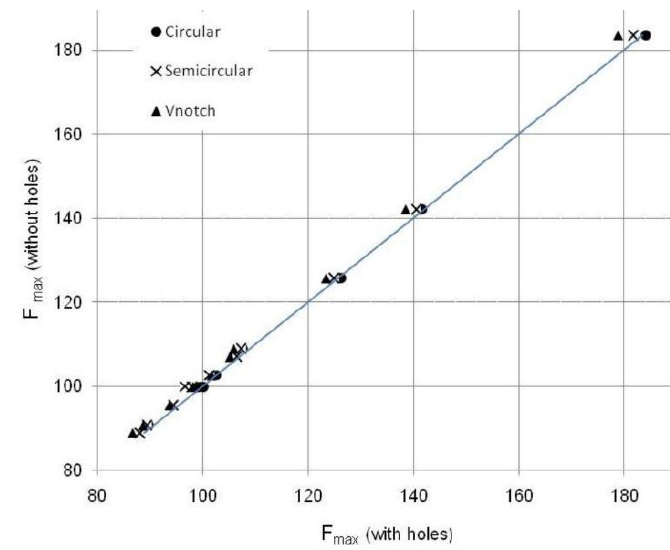
Figure 10. Comparison of maximum load in the joints with and without vent holes. Appl. Sci. 2019 , 9 , x FOR PEER REVIEW